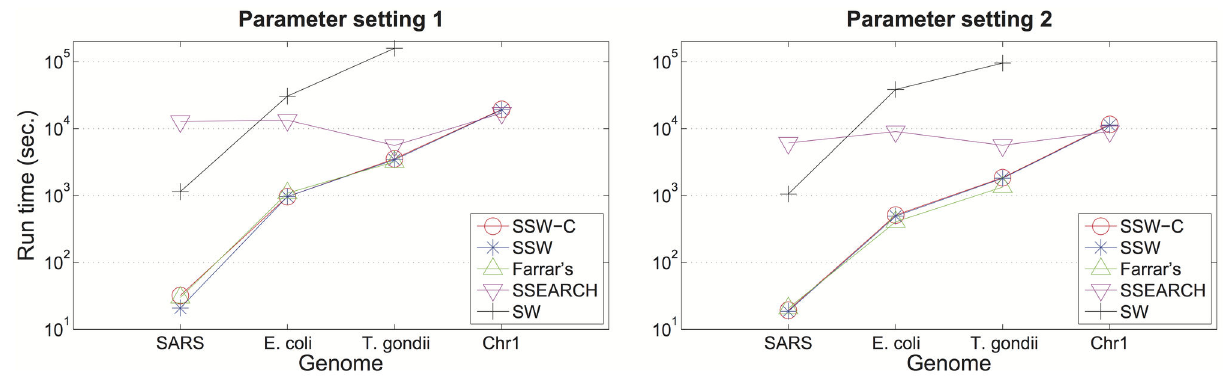
Figure 3. Running time of different SW implementations for real genomic read alignment. Running time of aligning 1,000 real sequencing reads to various microorganism genomes and the human chromosome 1 are shown. Farrar’s implementation cannot handle long sequences as human chromosome 1, so its corresponding running time is not shown here. The log-scaled running time is shown on the y-axis for SSW without (blue) and with (red) detailed alignment, Farrar’s implementation (green), SSEARCH (pink) and an ordinary SW implementation (black). All SW implementations were tested under two sets of SW parameters: scores of match, mismatch, gap open and extension are 2, -1, -2, and -1 respectively (left), and scores of match, mismatch, gap open and extension are 1, -3, -5, and -2 respectively (right).